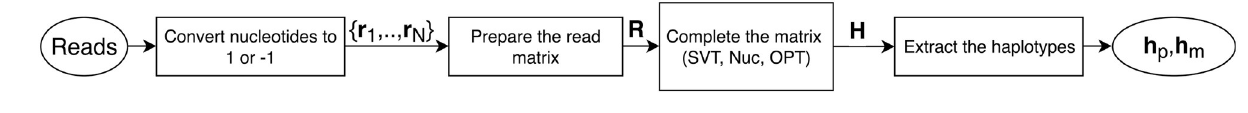
Fig 1. Block diagram of the proposed